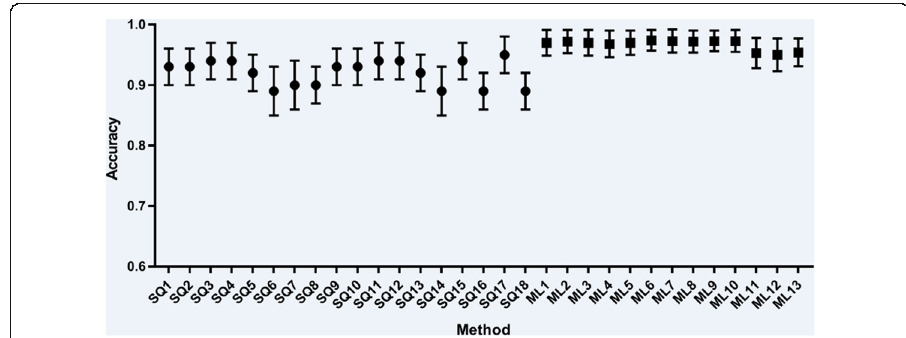
Fig. 4 Accuracy results for all semi-quantification and machine learning methods applied to PPMI data. Semi-quantification results are grouped to the left of the graph and machine learning algorithms to the right. Whiskers represent one standard